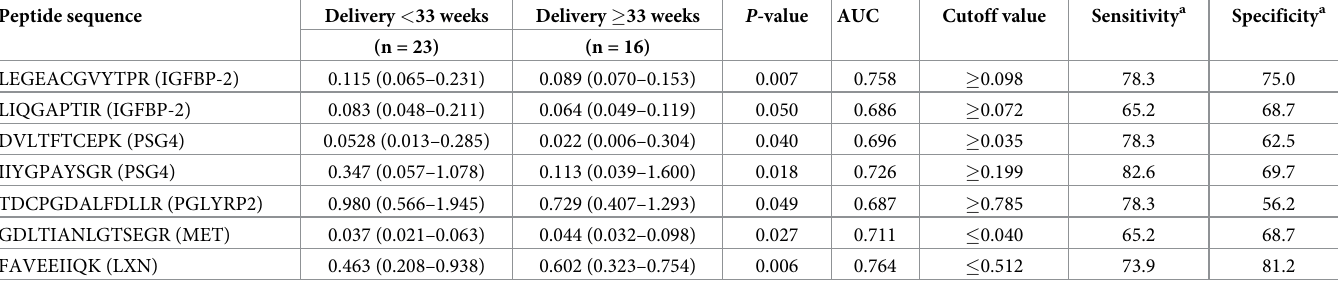
Table 1. The relative abundance of plasma biomarkers in relation to the occurrence of spontaneous preterm delivery at < 33 weeks after cerclage, areas under the curves, and optimal cut-off values for every protein. Peptide sequence Delivery < 33